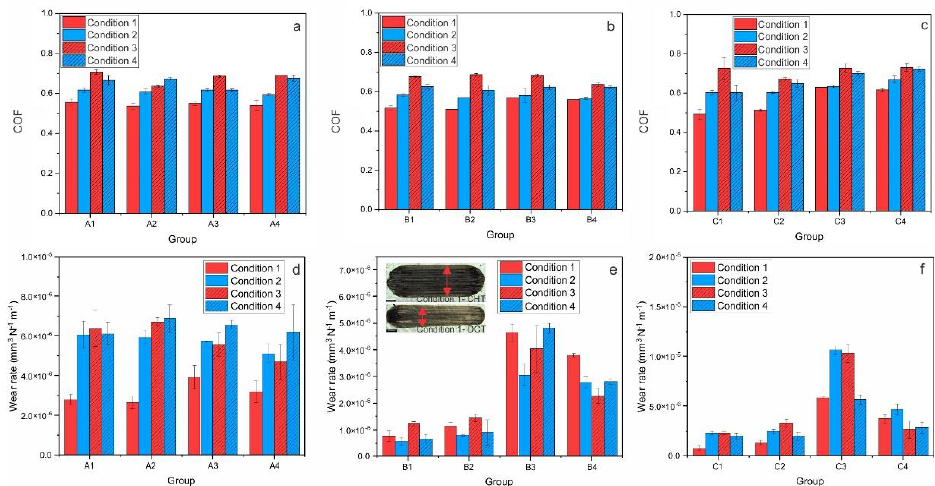
Figure 2. Results of abrasive wear conditions (Al 2 O 3 counter-body) for all three steels; A (AISI M2), B (AISI M3:2) and C (AISI M35), where ( a – c ) is steady-state coefficient of friction for each condition and ( d – f ) is wear rate for each steel at certain condition. ( e ) The insert shows the average representation of wear scar for all three steels of conventionally (CHT) and deep cryogenically heat-treated samples, the black scale represents 500 µm.